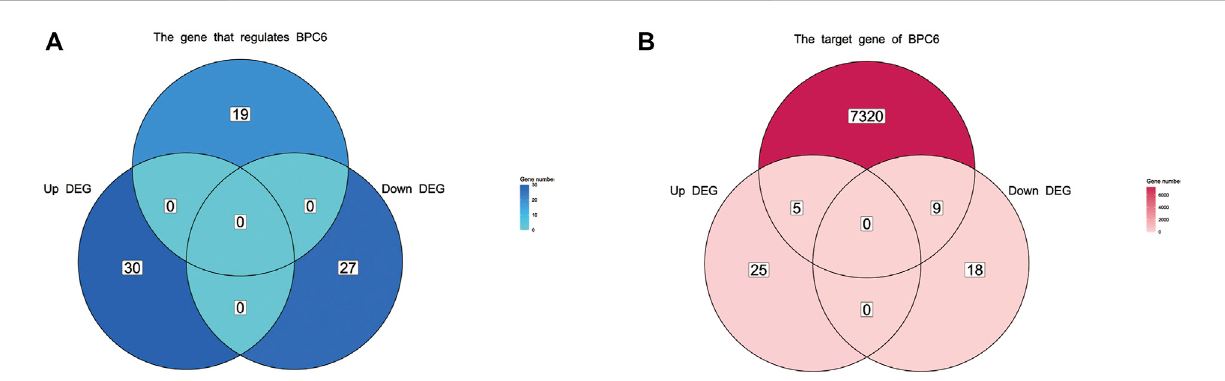
FIGURE 7 VenndiagramofdifferentiallyexpressedgenesandBPCupstreamregulatorygenesanddownstreamtargetgenes. (A) Venndiagramofdifferentially expressed genes and upstream regulatory genes of BPC. (B) Venn diagram of differentially expressed genes and target genes regulated by